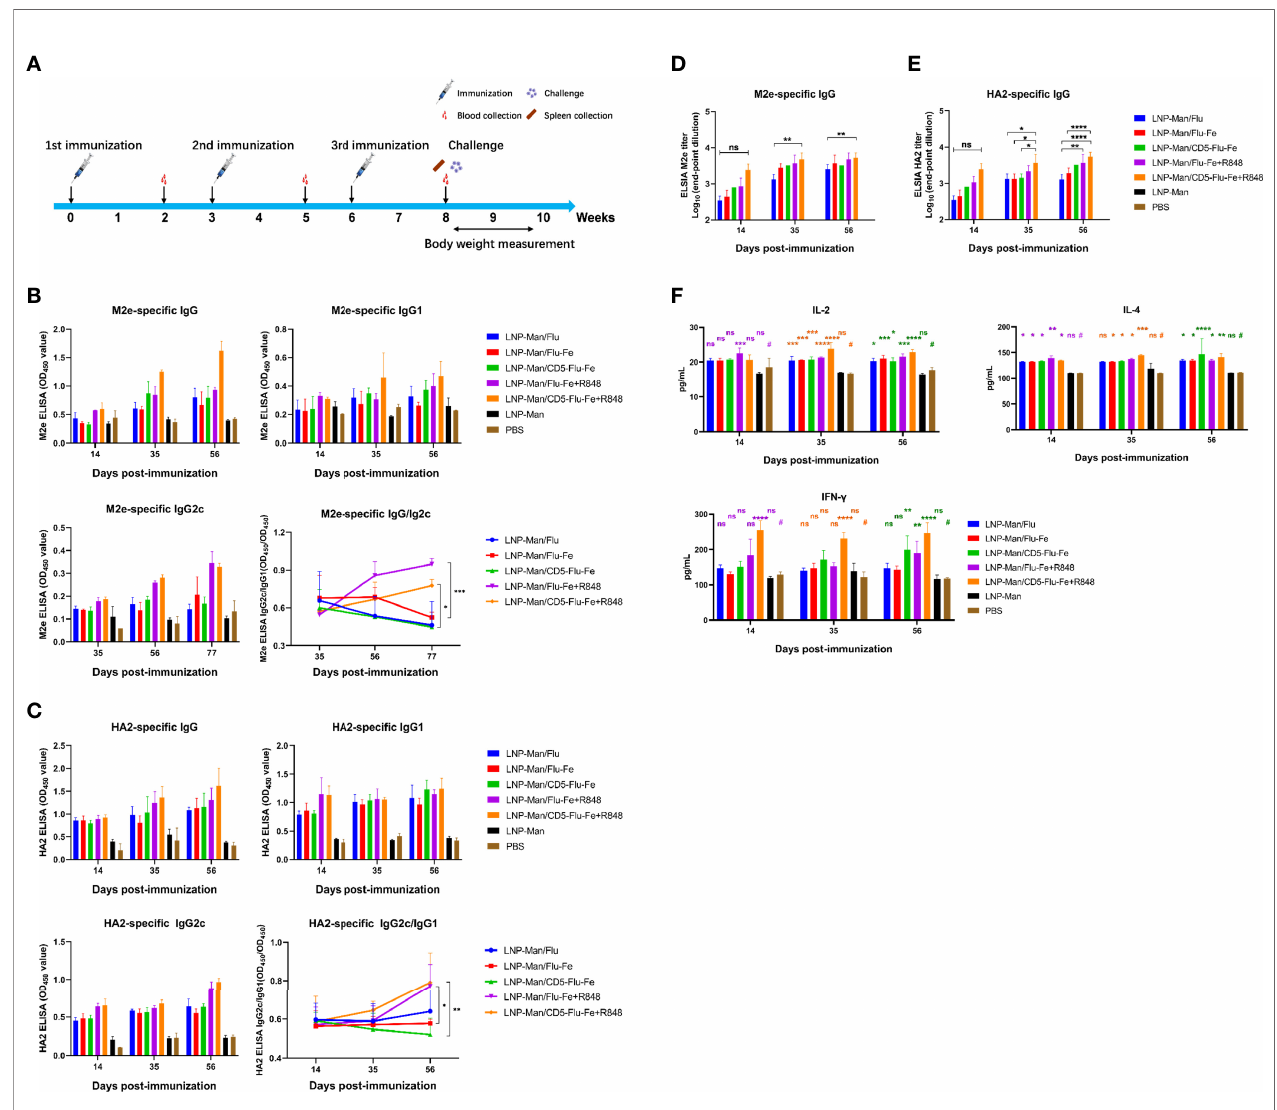
FIGURE 4 | Immune response induced by mRNA vaccine in mice. (A) Immune procedure and experimental plan at different time points; (B, C) The secretion levels of speci fi c antibodies IgG, IgG1, and IgG2cagainst M2e andHA2 in serum of mice on the 14th, 35th,and 56th daysafter immunization were detected byELISA (n= 3).The variation trend of IgG2c/IgG1 in serum after immunization was detected byELISA (n= 3). (D, E) The end-point titersof M2e-and HA2-speci fi c IgG antibody inmiceserum on the 14th, 35th,and 56th daysafter immunization (n = 3). (F) On the 14th, 35th,and 56th daysafter the fi rst immunization,the secretion levelsofIL-4, IL-2, and IFN- g inmice serum were detected bythe ELISA assay (n= 3). Data were shownas mean ± SDsandwere analyzed bytwo-way ANOVA ( ns p > 0.05; *p< 0.05; **p < 0.01; ***p < 0.001; ****p < 0.0001). # represents the PBS group and isused as a reference groupfor comparisonwith the rest of the